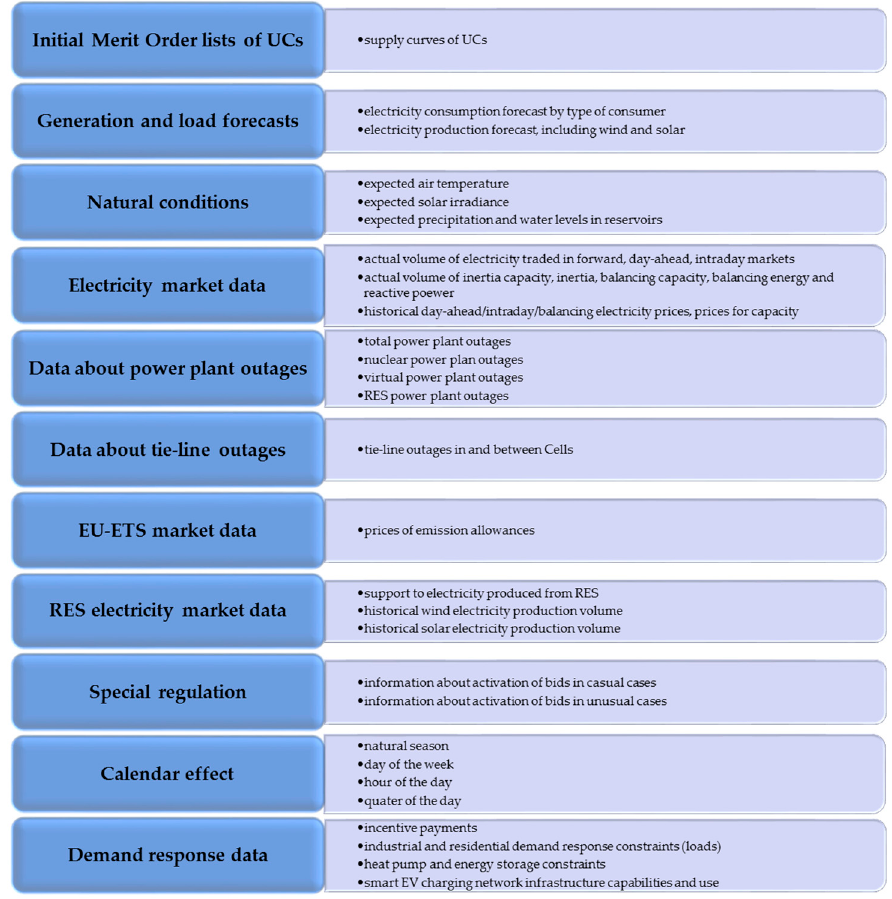
Figure 10. Data requested for the establishment of final Merit Order list.